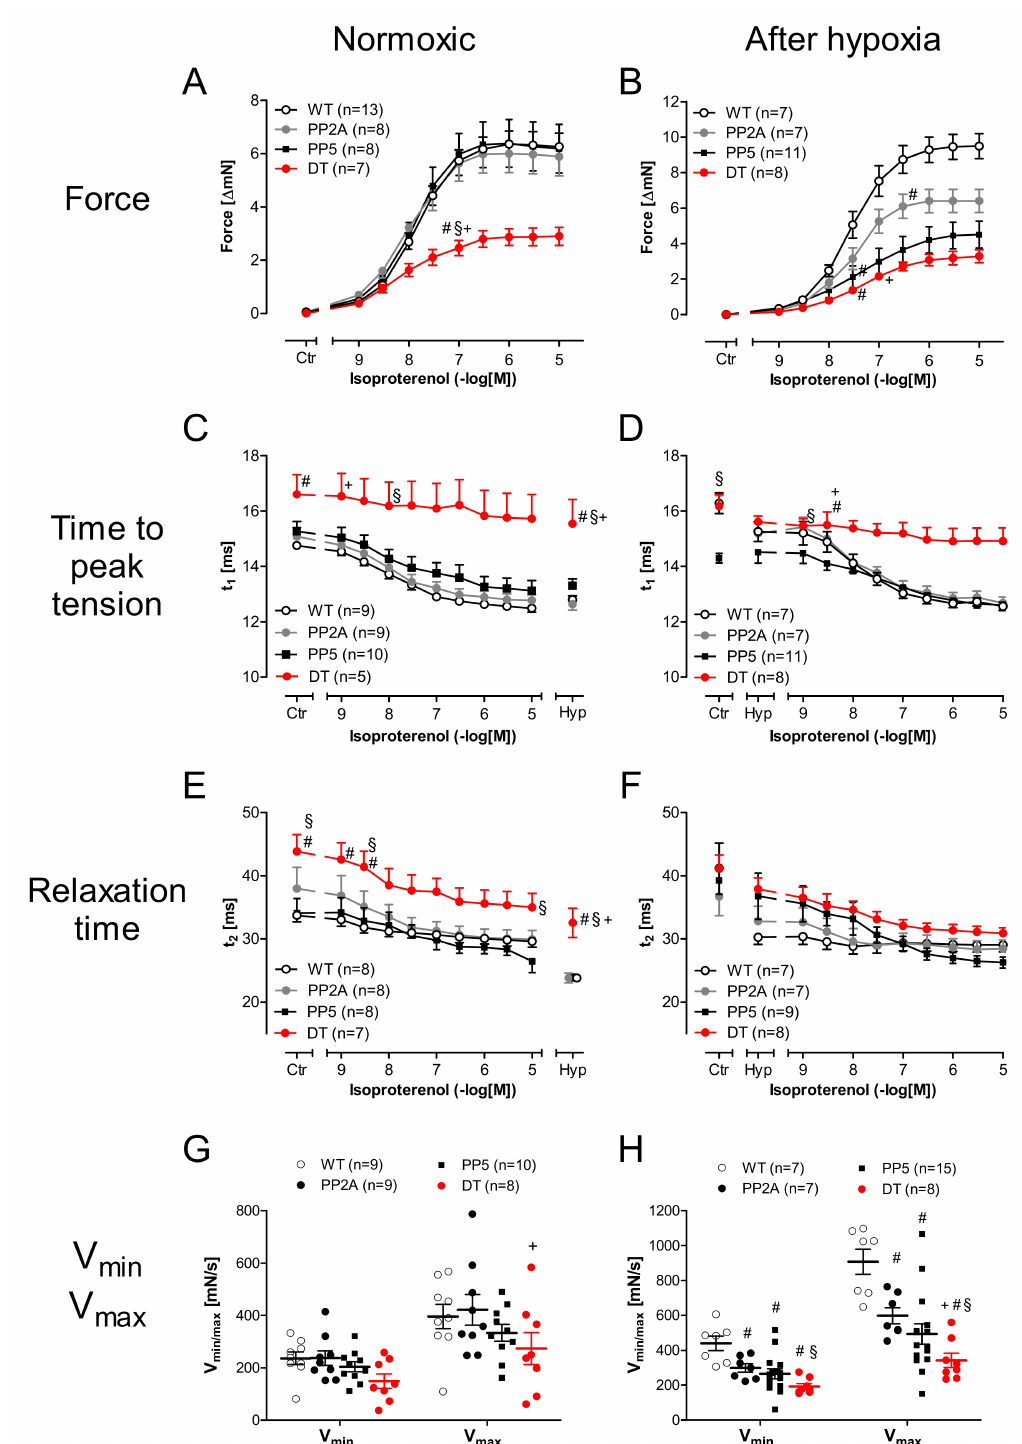
Figure 5. Cumulative concentration response curves of isoproterenol in isolated paced (1 Hz) atrial preparations under normoxic control conditions ( A , C , E , G ) or after hypoxia ( B , D , F , H )) in young (age group I) mice. ( A , B ): Cumulative concentration response curves of isoproterenol on force of contraction; ( C , D ): Cumulative concentration response curves of isoproterenol on time to peak tension. ( E , F ): Cumulative concentration response curves of isoproterenol on relaxation time. # first significant difference p < 0.05 vs. WT; + first significant difference p < 0.05 vs. PP2A; § first significant difference p < 0.05 vs. PP5; n = 5–12. ( G , H ): Cumulative concentration response curves of isoproterenol on minimum (V min ) and maximum (V max ) rate of tension development. # p < 0.05 vs. WT; + p < 0.05 vs. PP2A; § p < 0.05 vs. PP5; n =